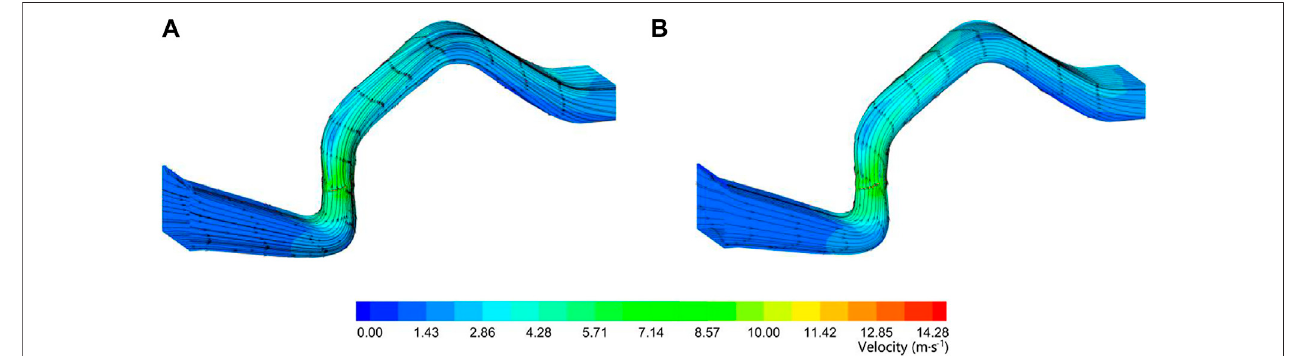
FIGURE 13 | Pump device fl ow fi elds with Δβ of 0 ° and − 12 ° , respectively. (A) Δβ = 0 ° , (B) Δβ = − 12 ° .